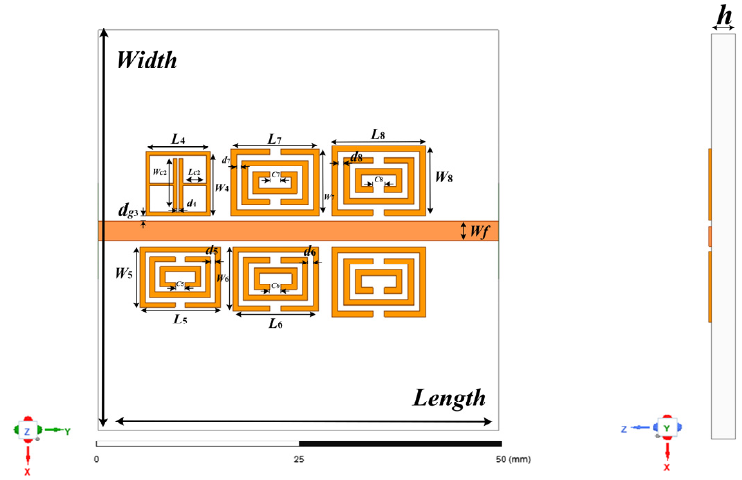
Figure 6. The 6-bit chipless RFID tag design.